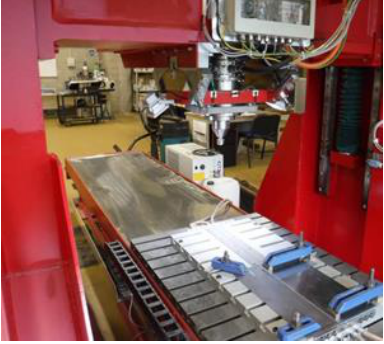
Figure 2. H. Loitz-Robotik Machine set up.